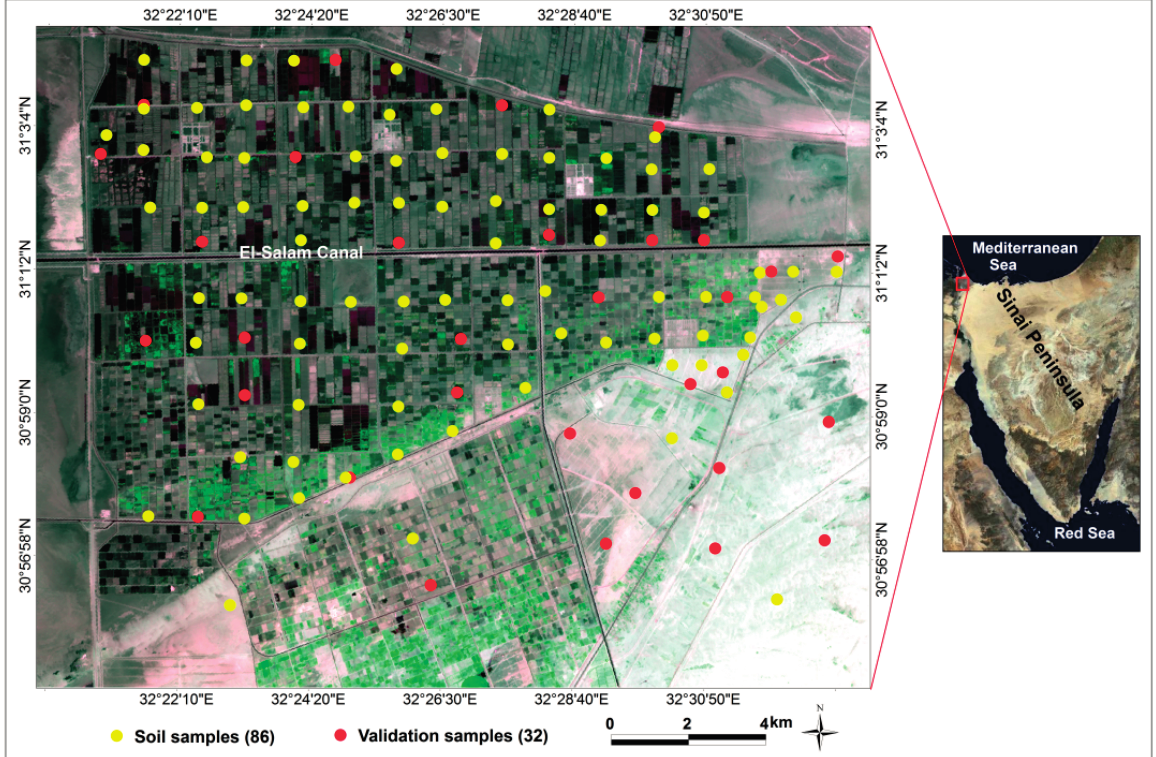
Figure 1. Study area shown in false color composite (RGB 132) of an ASTER image in 2006, as well as soil sample